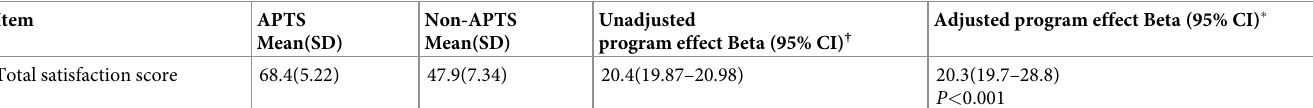
Table 7. Total satisfaction score reported by participants in APTS and Non-APTS primary